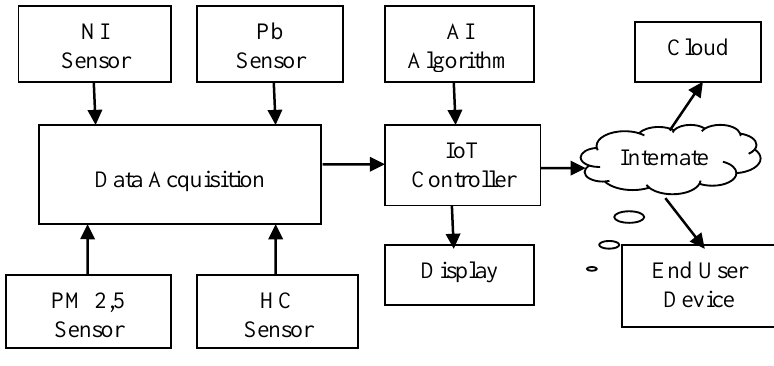
Fig.-2. Block Diagram of Proposed